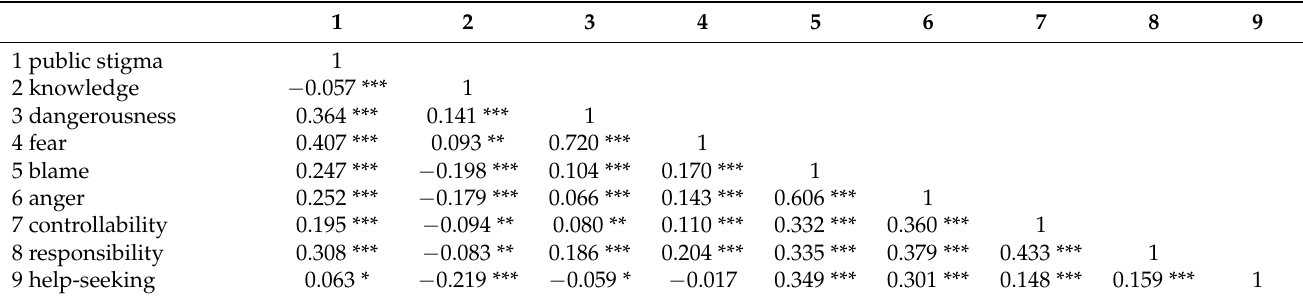
Table 3. Correlations between public stigma of COVID-19 and other continuous